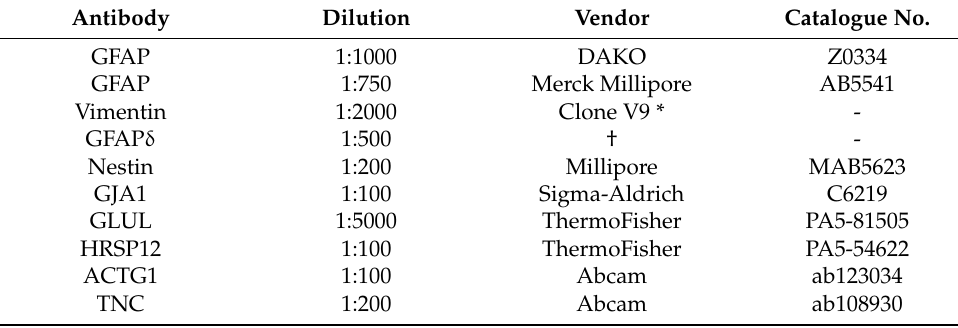
Table 2. List of antibodies used for